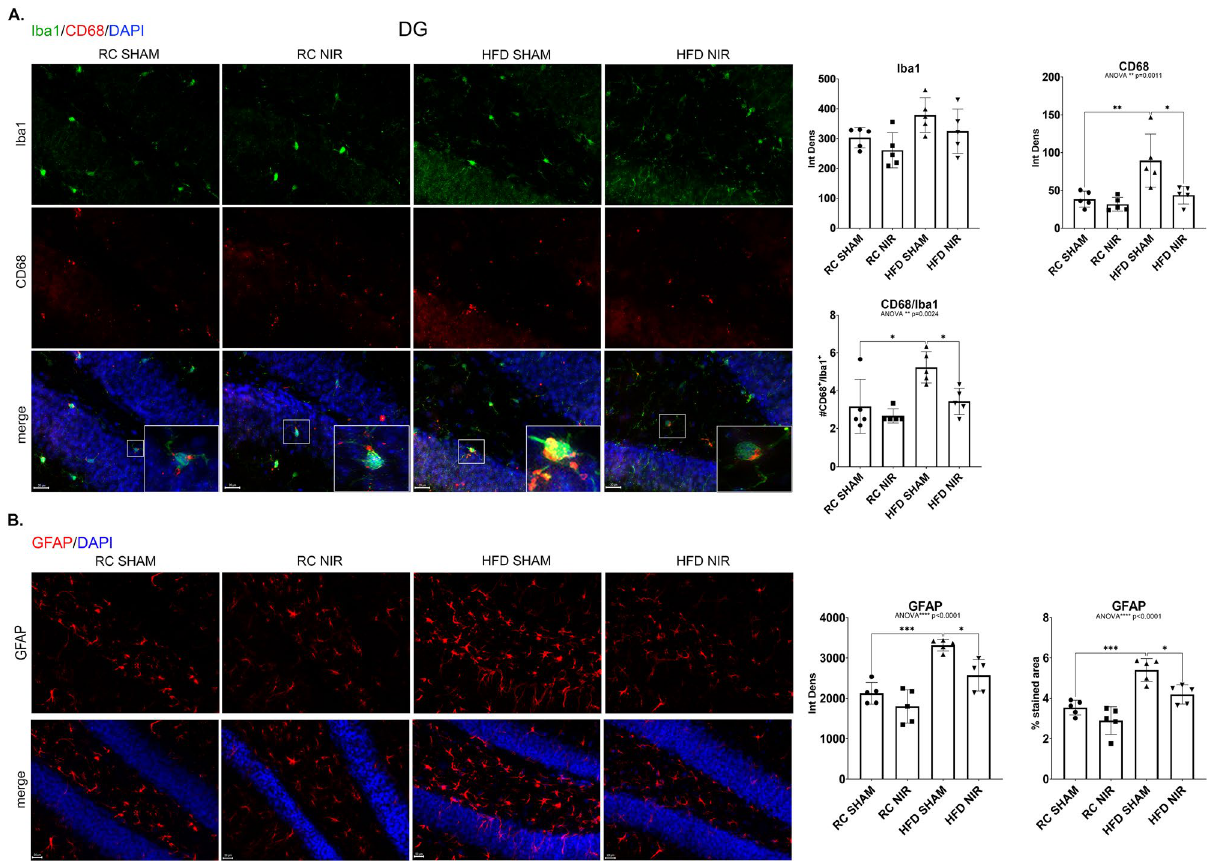
Figure 3. Glia marker expression in the DG of RC- and HFD-fed mice with or without NIR. ( A ) Iba-1 levels were not significantly different among the groups; CD68 was significantly elevated in the HFD group, but this was reversed by NIR. Magnification: 60X. ( B ) In the DG, NIR reduced HFD-induced astrocyte activation (GFAP immunoreactivity). Magnification: 40X. Image results of Z-stacks with pitch of 2.0 μm. n = 5 animals/ group. Data are presented as mean ± SD. Each point is the average of 6 images/animal from 2 technical replicates. Statistical analyses: one-way ANOVA with Tukey’s post-hoc test. * p < 0.05, ** p < 0.01, *** p < 0.001. Single images were generated with Keyence BZ-X800 Analyzer (www. keyen ce. com). Graphs were created with GraphPad Prism 8.4.3 and 9.3.1 software (https:// www. graph pad. com/). Images and graphs were composed in Adobe Photoshop 22.2.0 (https:// www. adobe. com/ produ cts/ photo shopf amily.